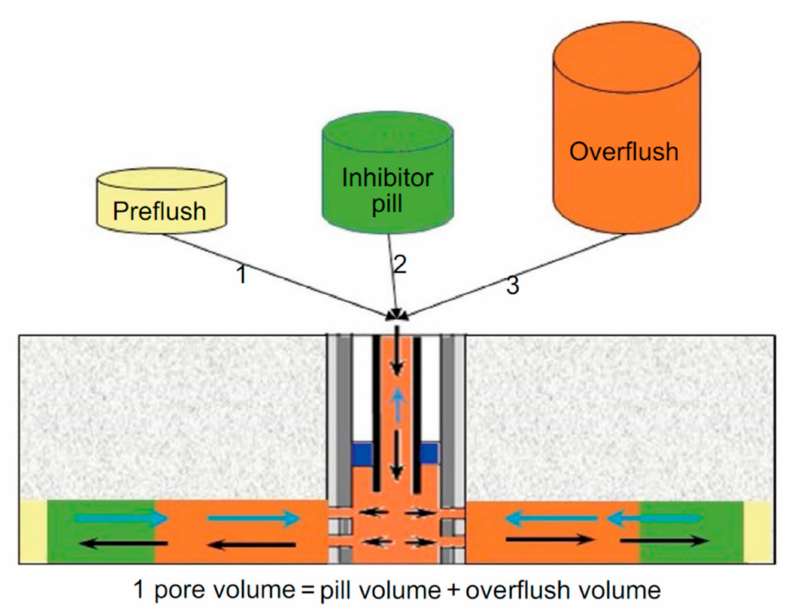
Figure 14. An illustration of a scale inhibitor squeeze treatment